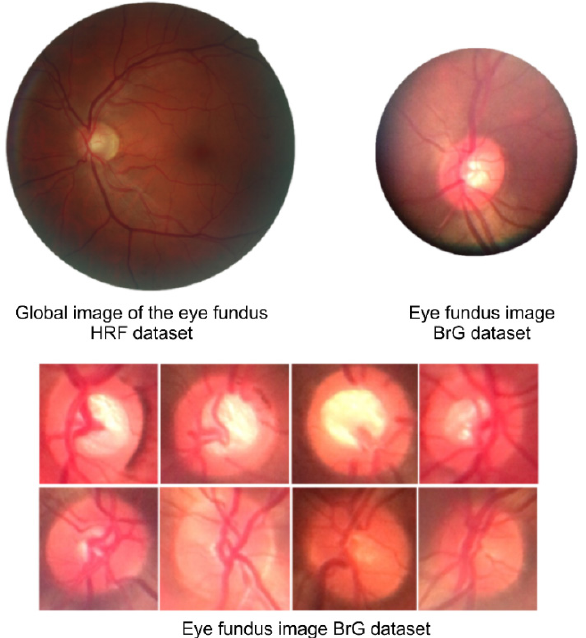
Figure 6. Fundus image comparison shows differences between global images and portable ophthalmoscope images that comprise the BrG dataset.